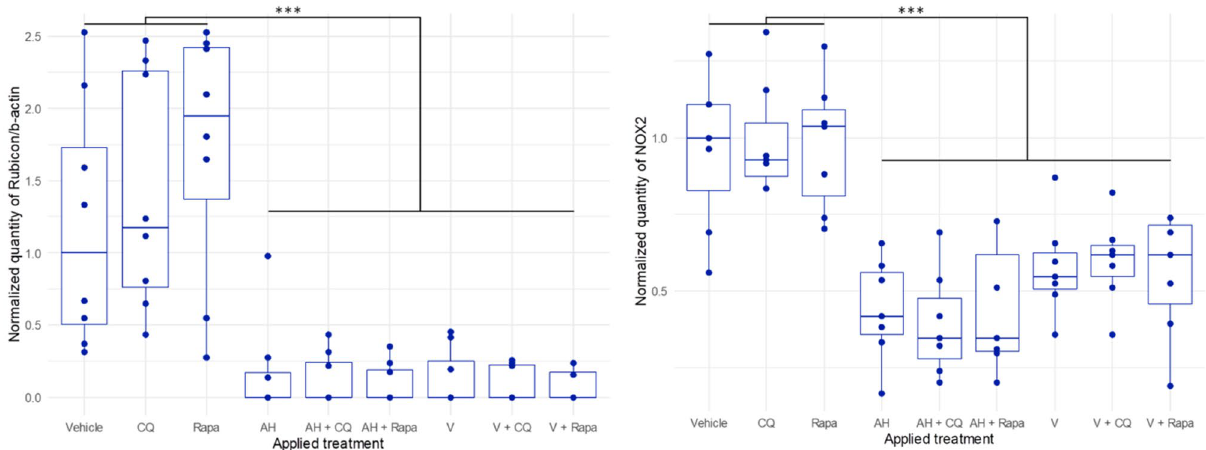
Figure 2. Expression level of Rubicon (left panel) and NOX2 (right panel) into differentiated PBMCs exposed 4 h with several treatments. CQ, Chloroquine, Rapa, Rapamycin, AH, Aluminum oxyhydroxide, V, Whole vaccine (Engerix ® ), *statistical differences at Durbin-Conover post-hoc test (*** p <